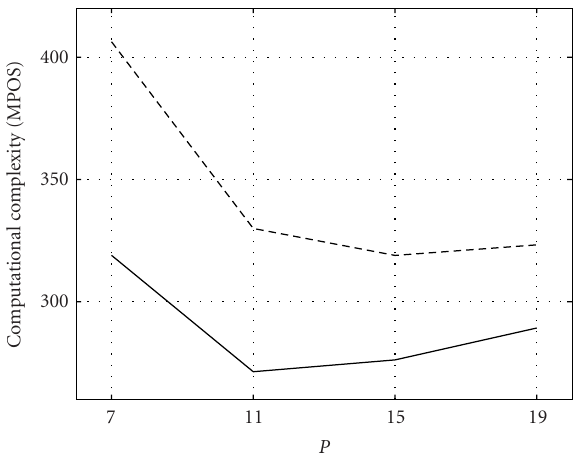
Figure 7: Computational complexities of the FTM simulations of a six-string guitar dependent on the number of bands for the multi- rate approach. Solid line: linearly vibrating string. Dashed line: vi- brating string with nonlinear slap